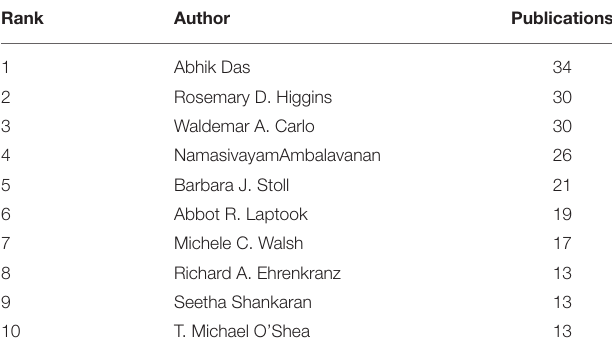
TABLE 3 | Top 10 authors with most publications on of BPD in extremely pre-mature infants.